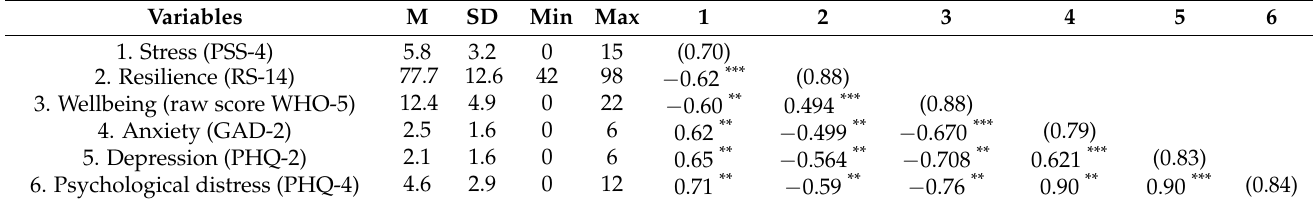
Table 2. Descriptive statistics and correlations between perceived stress, resilience, wellbeing, anxiety and depression.